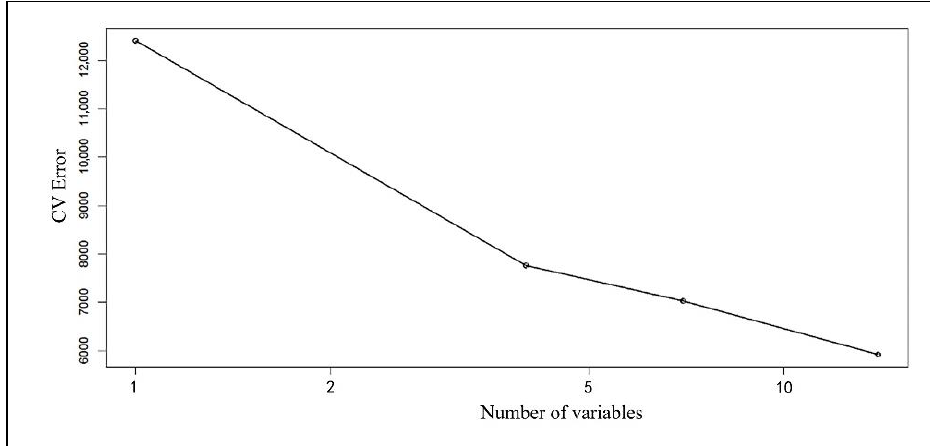
Figure 7. Ten-fold cross